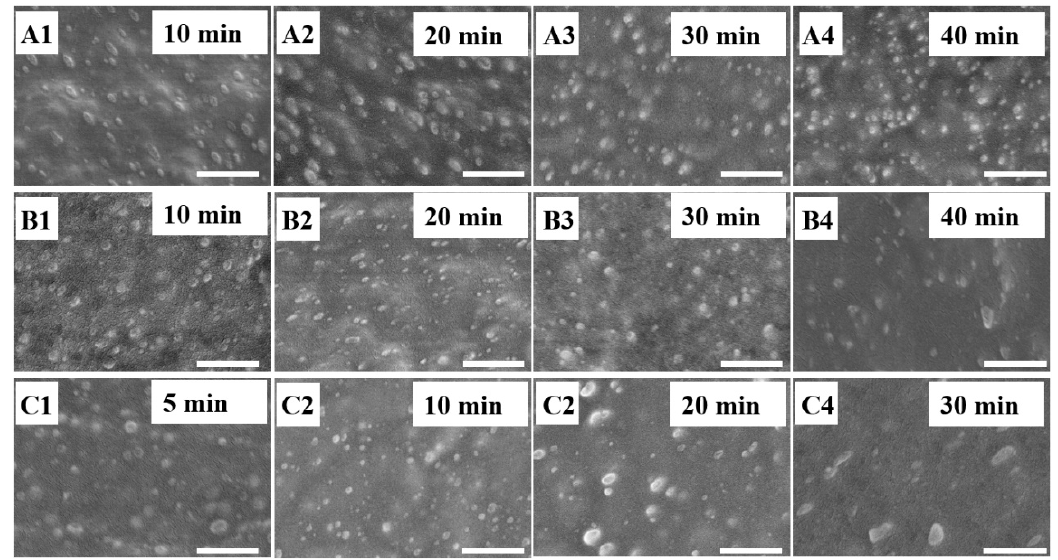
Figure 3. SEM images of PVDF/PLLA/RC of MG01 ( A1–4 ), MG02 ( B1–4 ), MG03 ( C1–4 ) mixed for the indicated time. The scale bar is 1 micron.